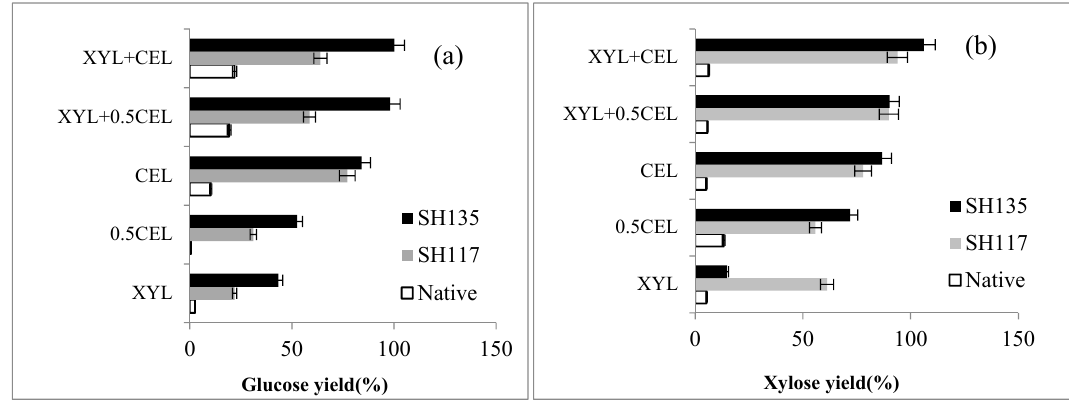
Figure 7. Hydrolysis of 2% pretreated bamboo by CEL (5, 10 FPU of Celluclast 1.5 L/g DM and 500 nkat of Novozyme 188/g DM) and/or XYL (2 mg protein/g DM) at 50 °C and pH 5.0 for 48 h ( a,b ). Error bars represent standard errors of two independent experiments.